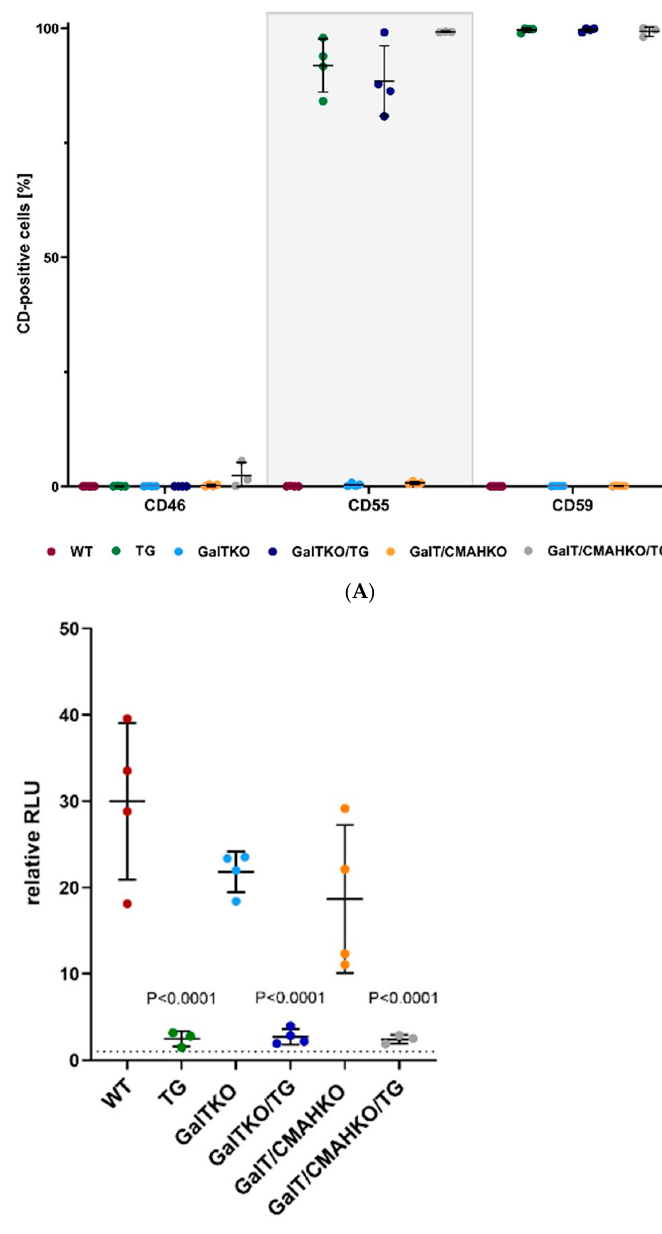
Figure 3. Expression of human transgenes in porcine chondrocytes. ( A ) Representative RT-PCR of WT and genetically modified porcine chondrocytes regarding human CD46, CD55, CD59, TNFAIP3; porcine GAPDH served as control (shown in Figure 1). The corresponding samples were loaded for electrophoresis in the following order: lane M: bp marker; lane 1: WT; lane 2: TG; lane 3: GalTKO; lane 4: GalTKO/TG; lane 5: GalT/CMAHKO; lane 6: GalT/CMAHKO/TG; NC: negative control ( B ) HMOX1 gene expression in human (hCH) and porcine chondrocytes (WT, TG and GalTKO/TG).